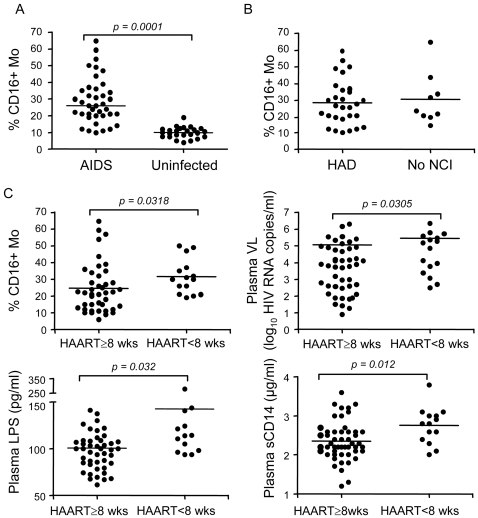
Increased CD16+ monocyte frequency in AIDS patients with and without HAD.(A) The frequency of CD16+ Mo within the total Mo population was analyzed in AIDS (n = 38) and uninfected subjects (n = 25). Total and CD16+ Mo were distinguished from granulocytes by HLA-DR and lack of CD16b/CD66b expression, and from NK cells by higher forward and side scatter characteristics (FSC and SSC), CD14, CD4, and CD33, and lack of CD56 expression [25]. (B) The frequency of CD16+ Mo was compared in AIDS patients with HAD (n = 29) and no NCI (n = 9). (C) The frequency of CD16+ Mo, plasma VL, and plasma levels of LPS and sCD14 were compared in patients receiving HAART ≥8 weeks (wks) and untreated or on HAART <8 wks. Median values are indicated as horizontal lines and statistical significance between groups was calculated using the Mann-Whitney test; significant differences (p<0.05) are indicated.